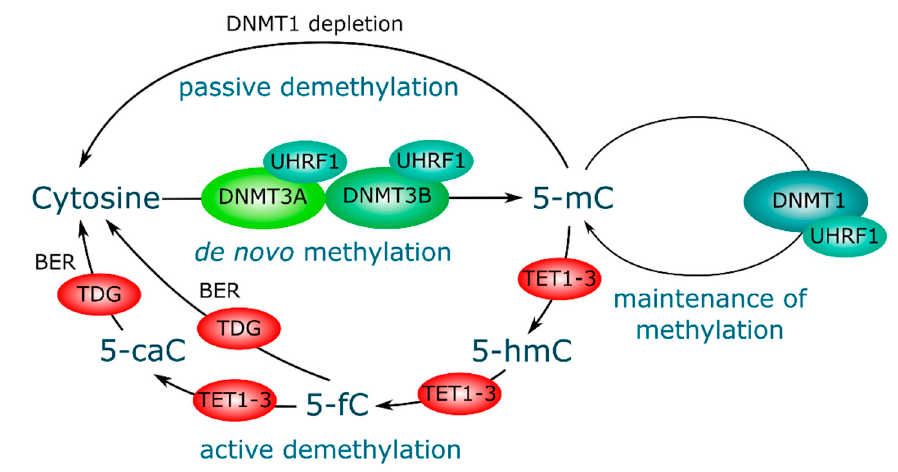
Figure 1. Mechanisms and key players of DNA methylation and demethylation.